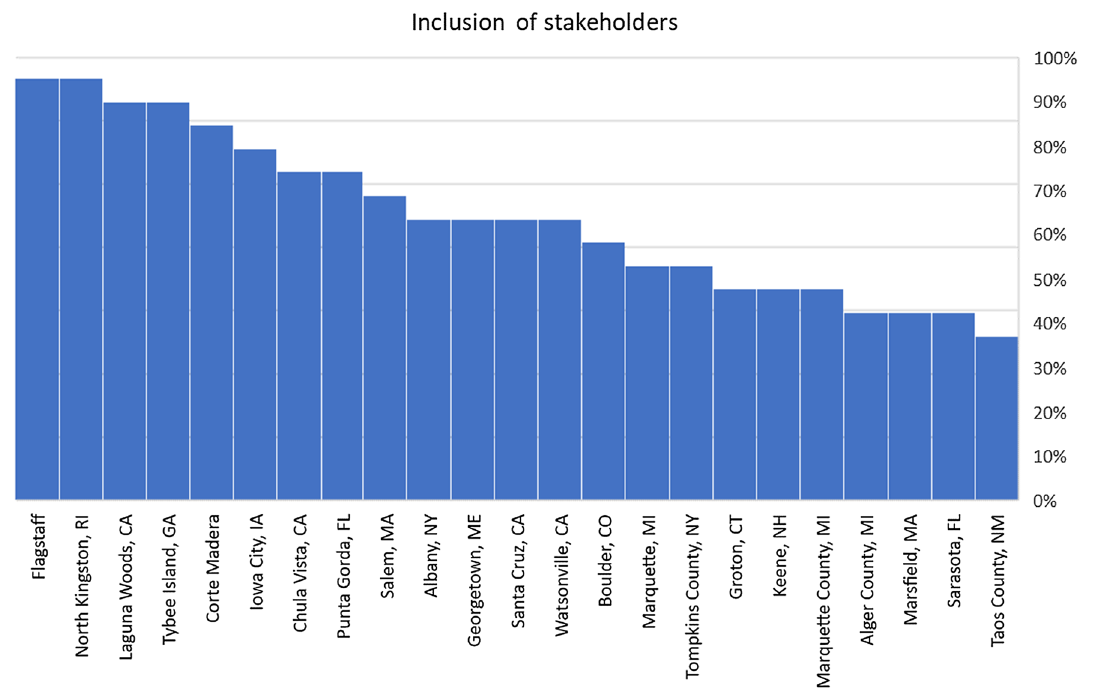
Fig. 3 Inclusion of stakeholder categories in the development of climate adaptation